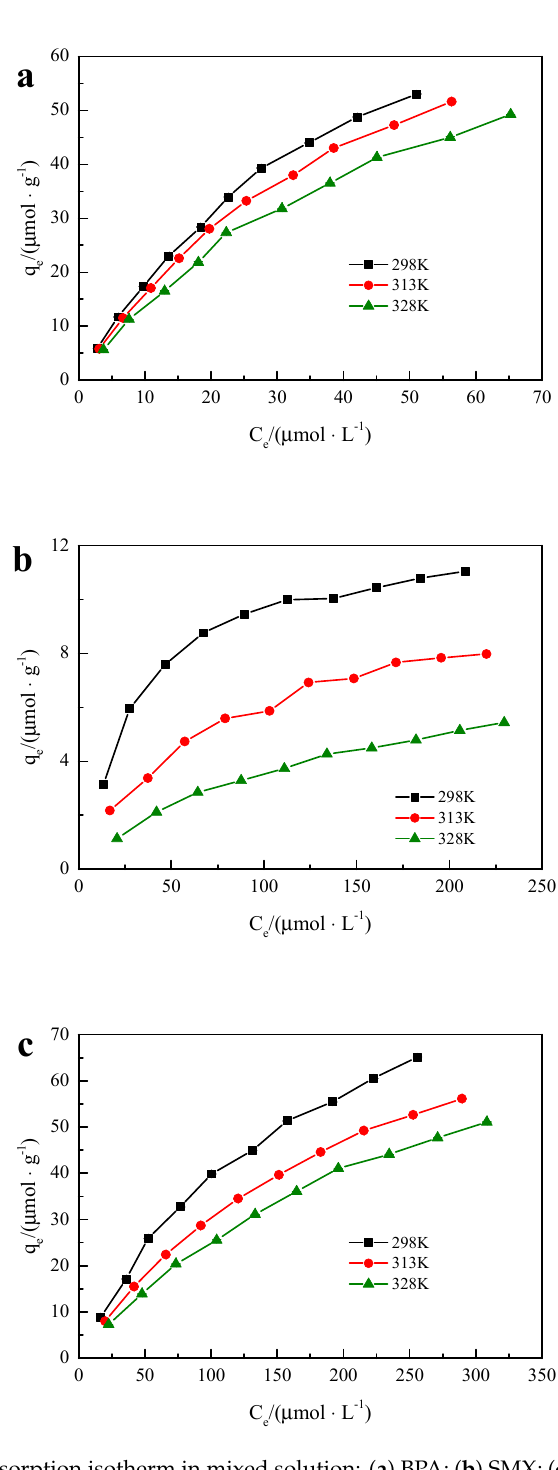
Figure 7. Adsorption isotherm in mixed solution: ( a ) BPA; ( b ) SMX; ( c ) BPA + SMX.